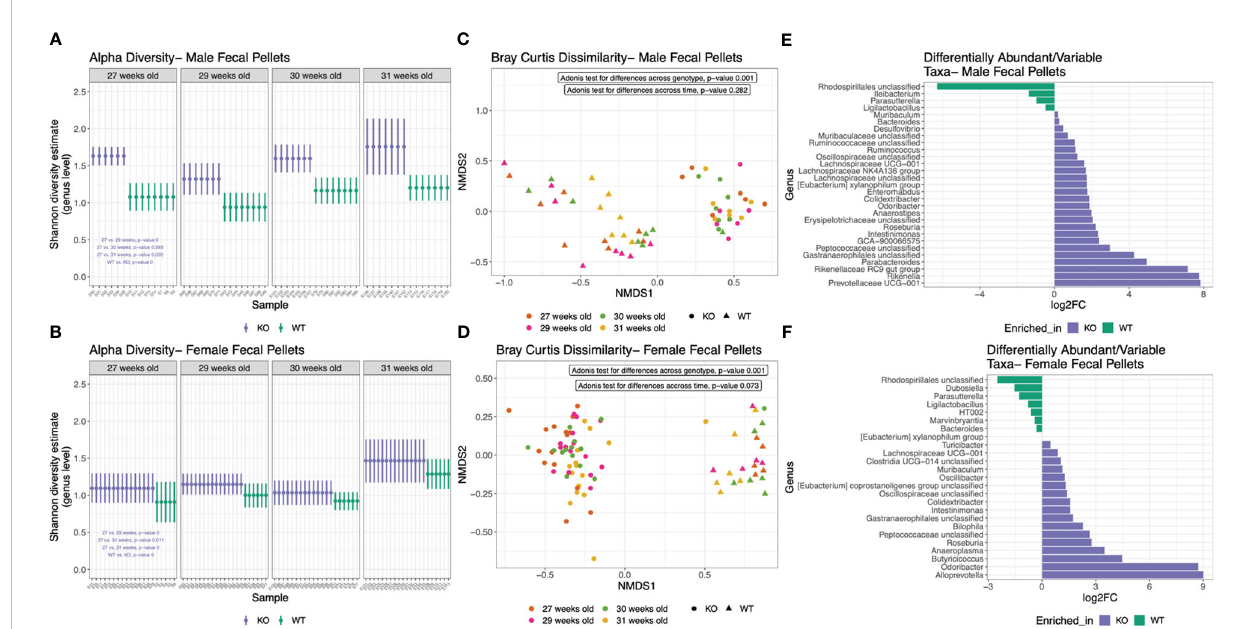
FIGURE 5 Nlrp12 de fi ciency induces dynamic changes in fecal microbiota diversity and composition. (A, B) Alpha diversity of fecal microbiota based on Shannon diversity estimate in male (A) and female (B) B6/ lpr mice upon alteration of NLRP12. (C, D) Non-metric multidimensional scaling (axes NMDS1 vs. NMDS2) showing the segregation of fecal microbiota overtime based on Bray Curtis dissimilarity of beta diversity in male (C) and female (D) mice. (E, F) Differentially abundant bacterial taxa at the genus level in male (E) and female (F) fecal